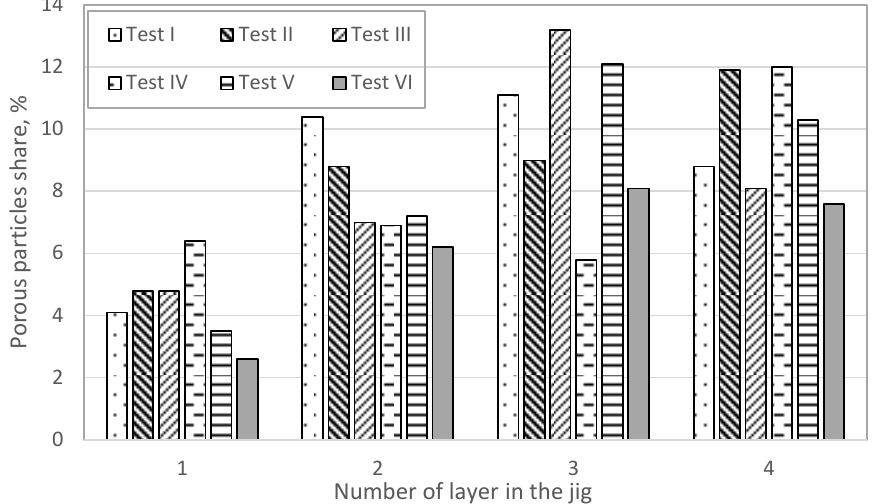
Figure 5. Characteristics of porosity of individual enrichment products for all laboratory tests.